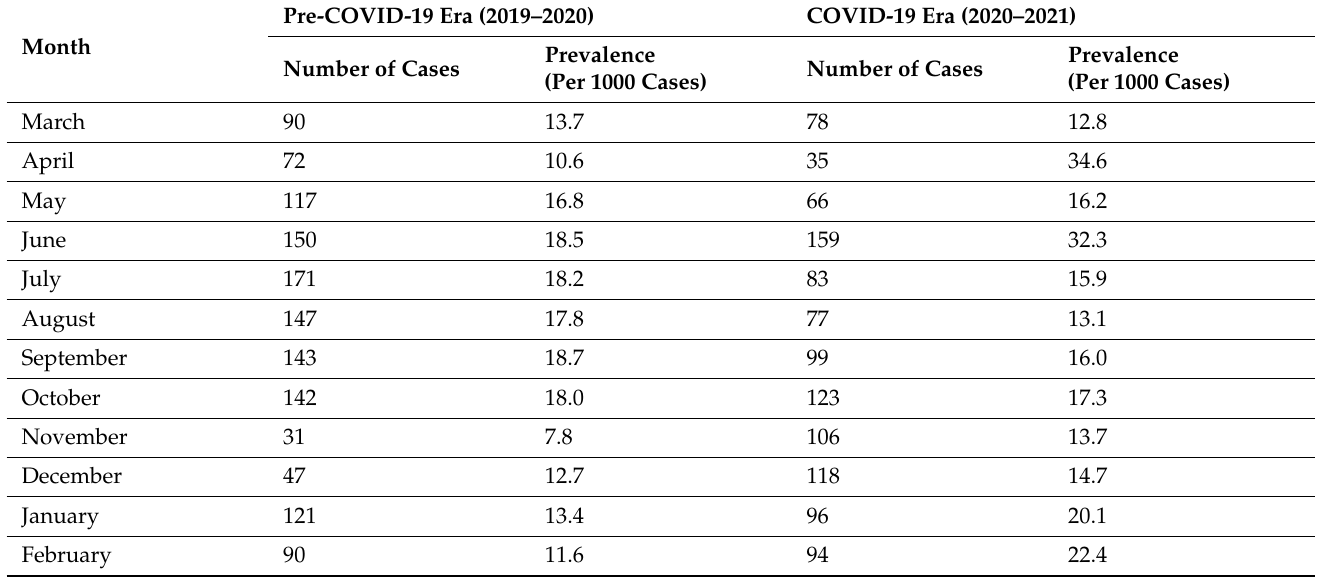
Table 5. Occurrence of cerebrovascular accident/stroke cases in the pre-COVID-19 and COVID-19